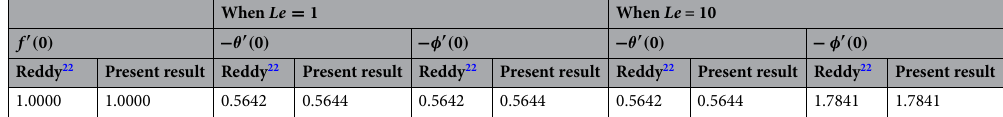
When Le = 1 When Le = 10 f ′ ( 0 ) − θ ′ ( 0